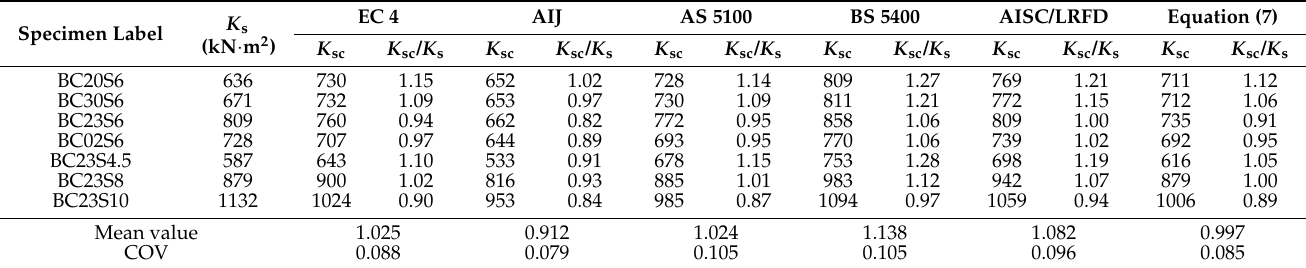
Table 8. Comparisons of the measured serviceability-level flexural stiffness with the predictions of design guidelines. Specimen